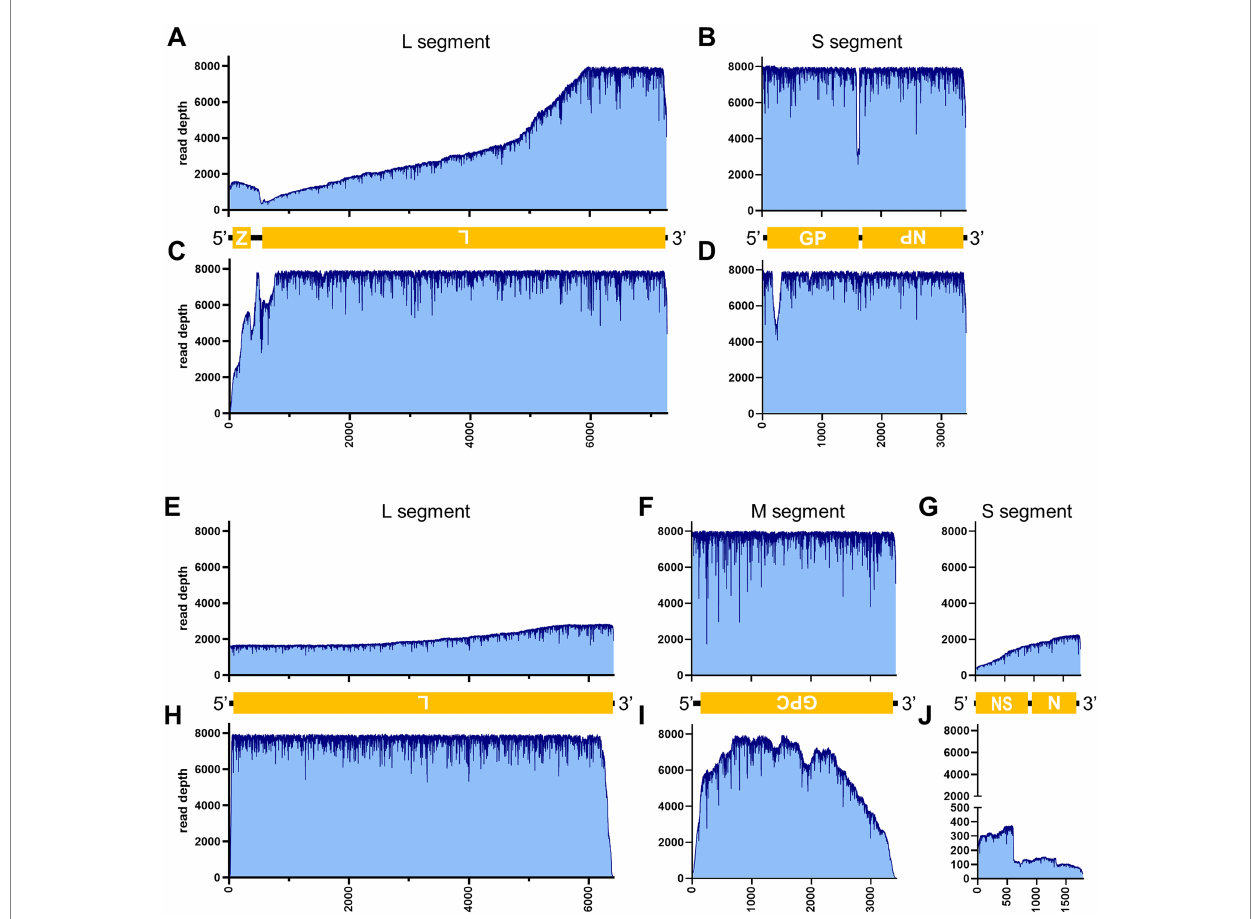
FIGURE 5 Read depth aligned to LCMV and SFTSV reference genomes. Read depth of LCMV (A–D) , and SFTSV (E–J) across the LCMV L (A,C) and S (B,D) segments and the SFTSV L (E,H) , M (F,I) , and S (G,J) segments using data generated from the PCR-NGS method [upper panels: (A,B,E–G) ] or RCA-NGS method [lower panels: (C,D,H–J) ] are shown. The schematic view of the open reading frames (ORFs) and UTRs are shown as yellow boxes and black lines in the 5 ′ -to-3 ′ direction. The product of ORF is shown in the box, and the turned letter indicates the ORF is in the reverse complement (i.e., 3 ′ -to- 5 ′ direction). In addition, the number of reads (y-axis) obtained at each nucleotide base pair position (x-axis) is